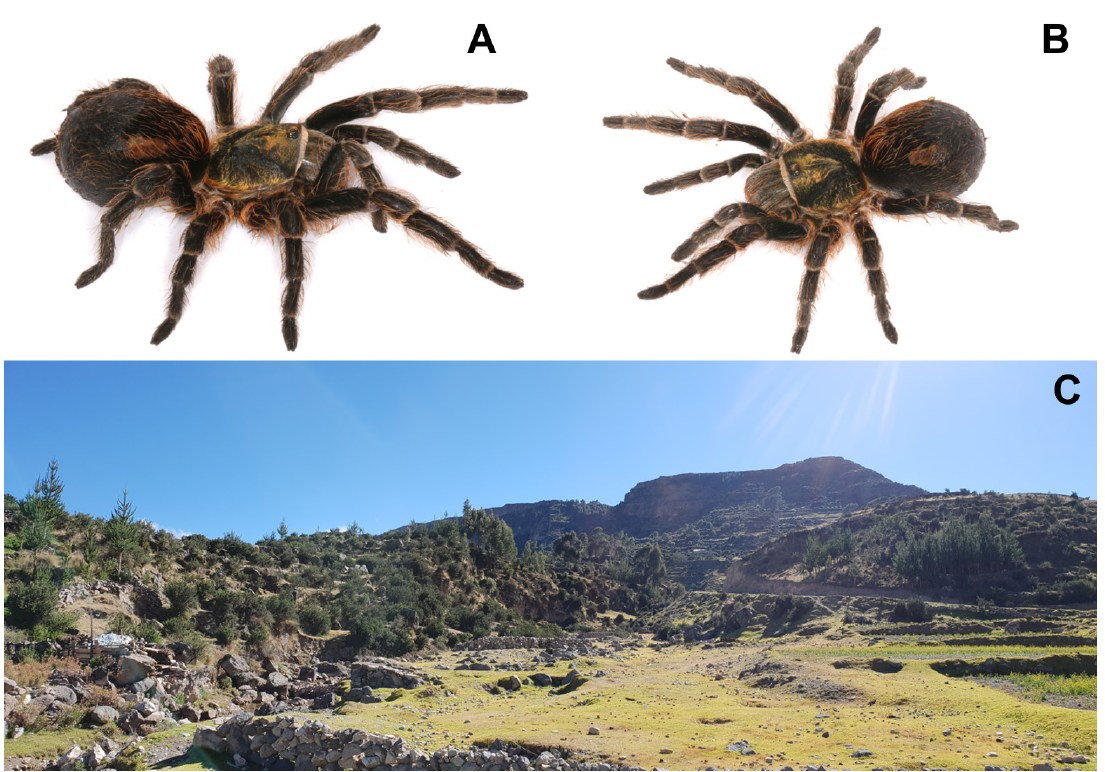
Fig. 5. Bistriopelma peyoi sp. nov., paratype, ♀ (MUBI 70). A – B . Habitus. C . Habitat at type locality. Photos: Juan C.